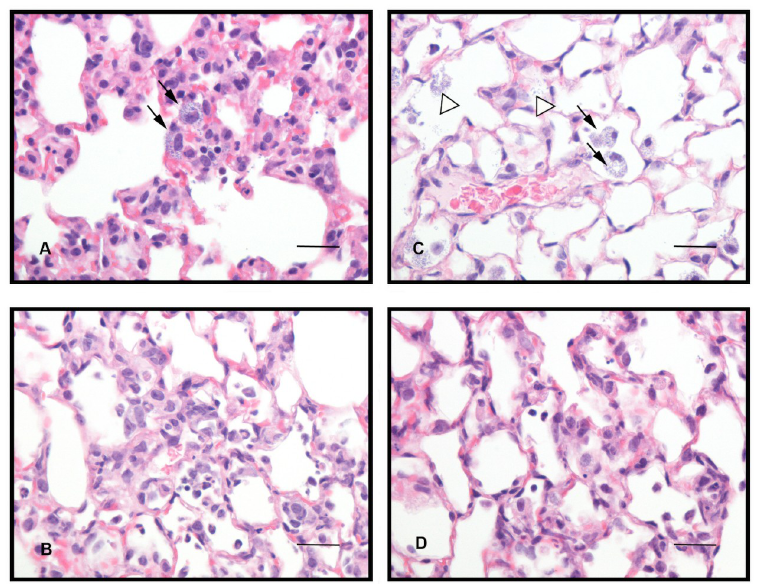
Fig 5. Sections of pulmonary parenchyma after IT and OP infection with A . baumannii ACC001 of VEH and TGC treated mice. Extracellular and intracellular bacteria were detected in untreated mice infected with both intratracheal (IT) (A) and oropharyngeal (OP) (C) techniques, with concurrent inflammation (hematoxylin and eosin staining, 600x magnification). Arrows indicate presence of bacteria in the cytoplasm of macrophages (black arrows) and in the extracellular space (white arrows). No bacteria were noted in mice treated with tigecycline (TGC) 120 mg/ day and challenged by both intratracheal (IT) (B) and oropharyngeal (OP) (D) routes, with inflammatory changes similar in severity and distribution to untreated animals (hematoxylin and eosin staining, 600x magnification). All scale bars represent 30 μ